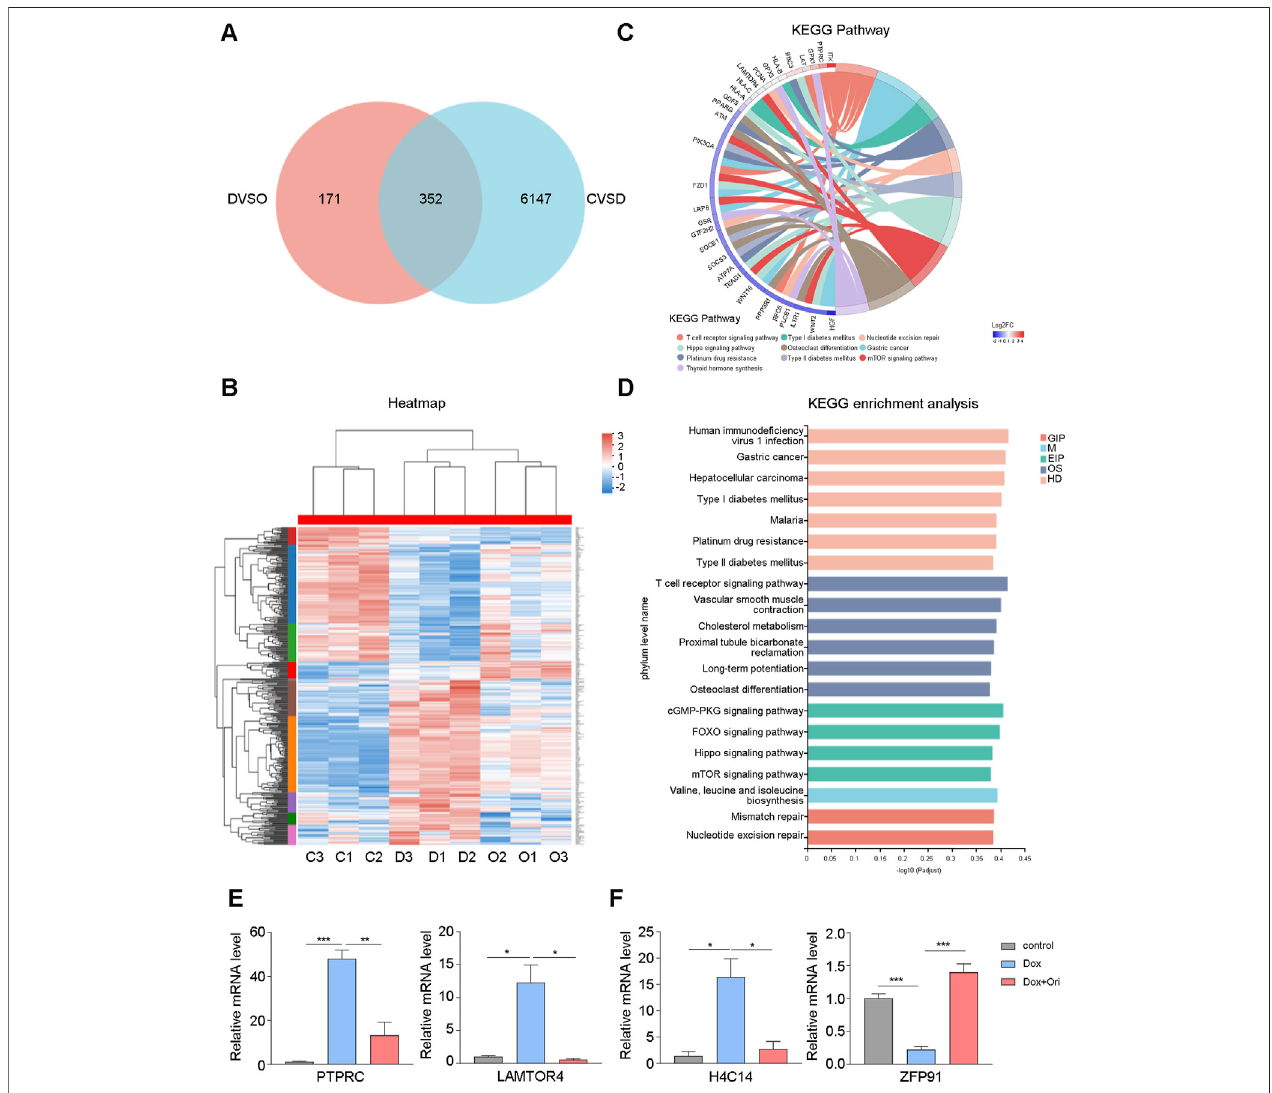
FIGURE 7 | Oridonin reverses the gene changes caused by doxorubicin-induced cell senescence. WI-38 cells were fi rst induced with 1 μ M doxorubicin for 12 h, and then treated with oridonin or DMSO-containing medium for 48 h. (A) The differential gene (CVSD) produced by doxorubicin-induced cell senescence and the differentialgene(DVSO)producedbyoridonintreatmentofdoxorubicin-inducedsenescentcellswereusedforVennanalysis. (B) Geneheatmap:theintersectiongeneof the differential gene (CVSD) produced by doxorubicin-induced cell senescence and the differential gene (DVSO) produced by oridonin treatment doxorubicin- induced senescent cells. (C) Chord plot of KEGG terms: the intersection of the differential gene (CVSD) produced by doxorubicin-induced cell senescence and the differential gene (DVSO) produced by oridonin treatment of doxorubicin-induced senescent cells. (D) KEGG enrichment analysis: the intersection of the differential gene (CVSD) produced by doxorubicin-induced cell senescence and the differential gene (DVSO) produced by oridonin treatment doxorubicin-induced senescent cells. Different colors indicate the 7 branches of the KEGG metabolic pathway, namely metabolism (M), genetic information processing (GIP), environmental information processing(EIP), cellularprocesses(CP),biologicalsystems(OS),andhumandiseases(HD), DrugDevelopment(DD). (E) Quantitative PCRanalysisofgeneexpression. (F) Quantitative PCR analysis of the histones and ubiquitin ligases ( A – F , n = 3 for each group). Data represent the mean ± SEM. one-way ANOVA or Student ’ s t-test determined p values. (* p < 0.05, ** p < 0.01, *** p < 0.001, **** p <